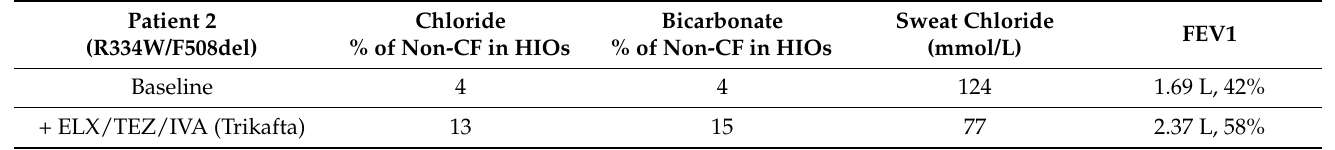
Table 2. ELX/TEZ/IVA-dependent improvement of CFTR-mediated anion transport in epithelial monolayers and clinical outcomes of Trikafta treatment in Patient 2 (R334W/F508del). In vitro